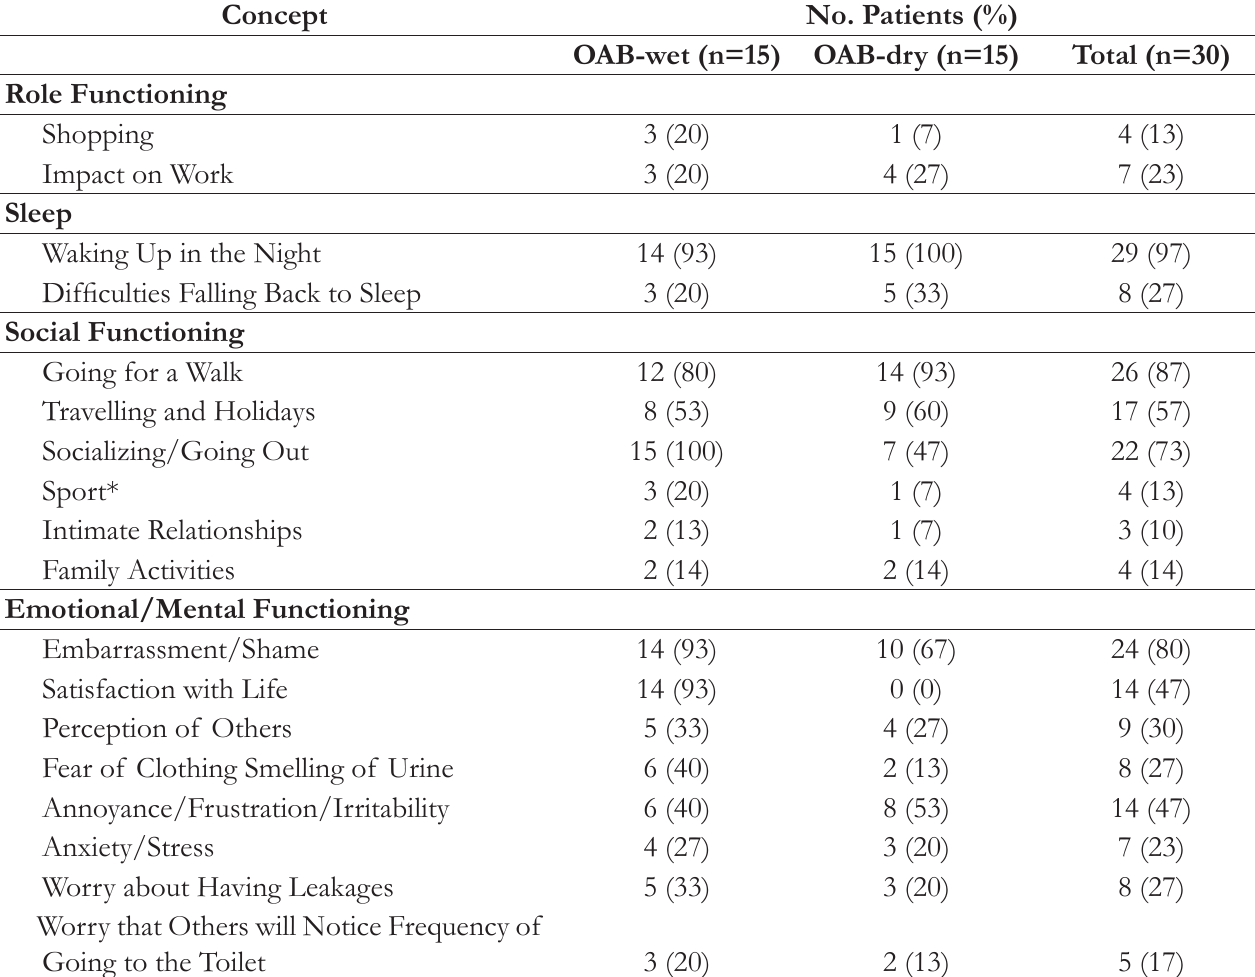
Table 3. Factors Affecting Quality of Life in Patients with OAB (Reported by >5% of